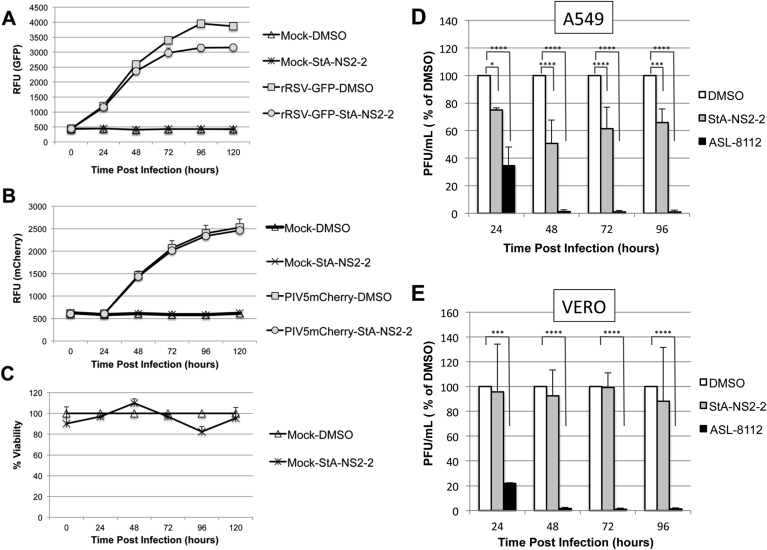
Effect of StA-NS2-2 on replication of rRSV-GFP and PIV5mCherry. A549 cells were treated with StA-NS2-2 (5 μM) or the equivalent volume of DMSO 24 h prior to infection with (A) rRSV-GFP or (B) PIV5mCherry at an MOI of 2.5 for 1 h at 37 °C. Mock-infected cells were subjected to the same procedure but incubated with media instead of virus stock. Following infection cells were maintained in DMEM containing 1% FBS and StA-NS2-2 (5 μM) or the equivalent volume of DMSO. Fluorescence (GFP or mCherry) was monitored as RFU every 24 h post-infection. (C) In parallel, mock-infected A549 cells were treated as above and % cell viability monitored using PrestoBlue cell viability reagent at each time point. DMSO-treated cells were set at 100% viability. Data shown represents mean values (n = 4 replicates; error bars = SD) and is representative of at least 3 independent experiments. (D and E) A549 or Vero cells were treated with StA-NS2-2 (5 μM) or the equivalent volume of DMSO 24 h prior to infection with rRSV-GFP (MOI 1). Following infection cells were maintained in DMEM containing 1% FBS and StA-NS2-2 (5 μM) or the equivalent volume of DMSO. At 24, 48, 72 and 96 h post infection supernatant was collected and stored at −80 °C. Infectious titer was determined by plaque assay using HEP2-BVDV-Npro cells. Each plaque assay was performed in triplicate and average titer (PFU/mL) determined. Data is presented as % of DMSO, which is set at 100% and represents the average of 3 independent experiments (n = 3; error bars = SD). Statistical significance was assessed using two-way ANOVA with Dunnett's multiple comparison test to compare effect of test compounds compared to DMSO control; *, p < 0.05, ***, p < 0.001, ****, p < 0.0001.